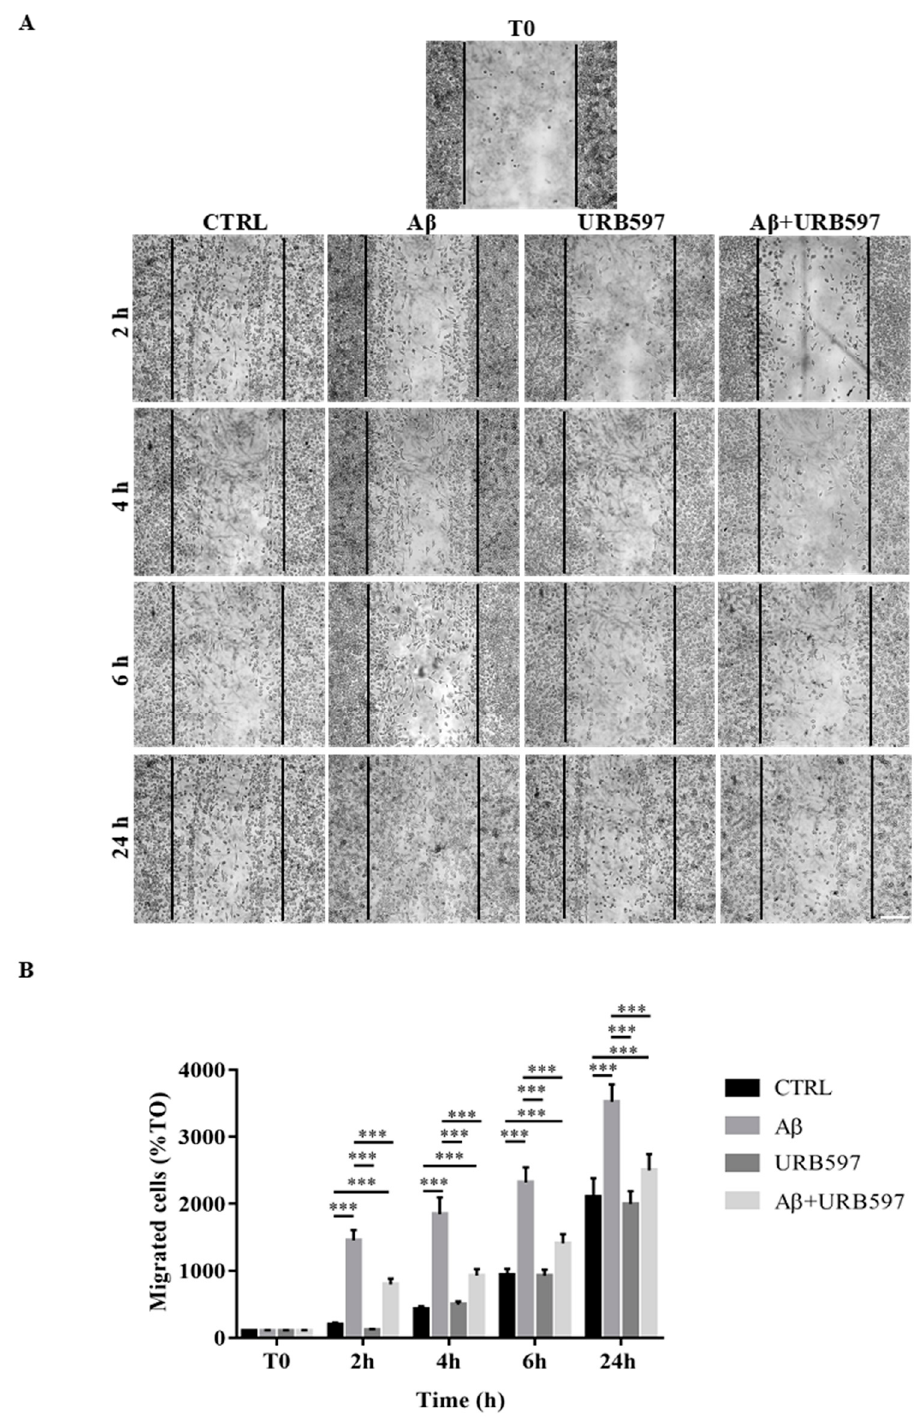
Figure 5. ( A ) Analysis of cell migration determined by scratch assay. BV-2 were pre-treated with 5 µM URB597 for 4 h in the presence or absence of 30 µM A β 25–35 for 2 h, 4 h, 6 h, and 24 h. T0 represents the control at time 0, and CTRL the control for each time point. ( B ) The results were normalized vs. T0 sample and re-ported as percentage. They represent the mean ± SD of three independent experiments. *** p < 0.001. Bar: 200 µm.